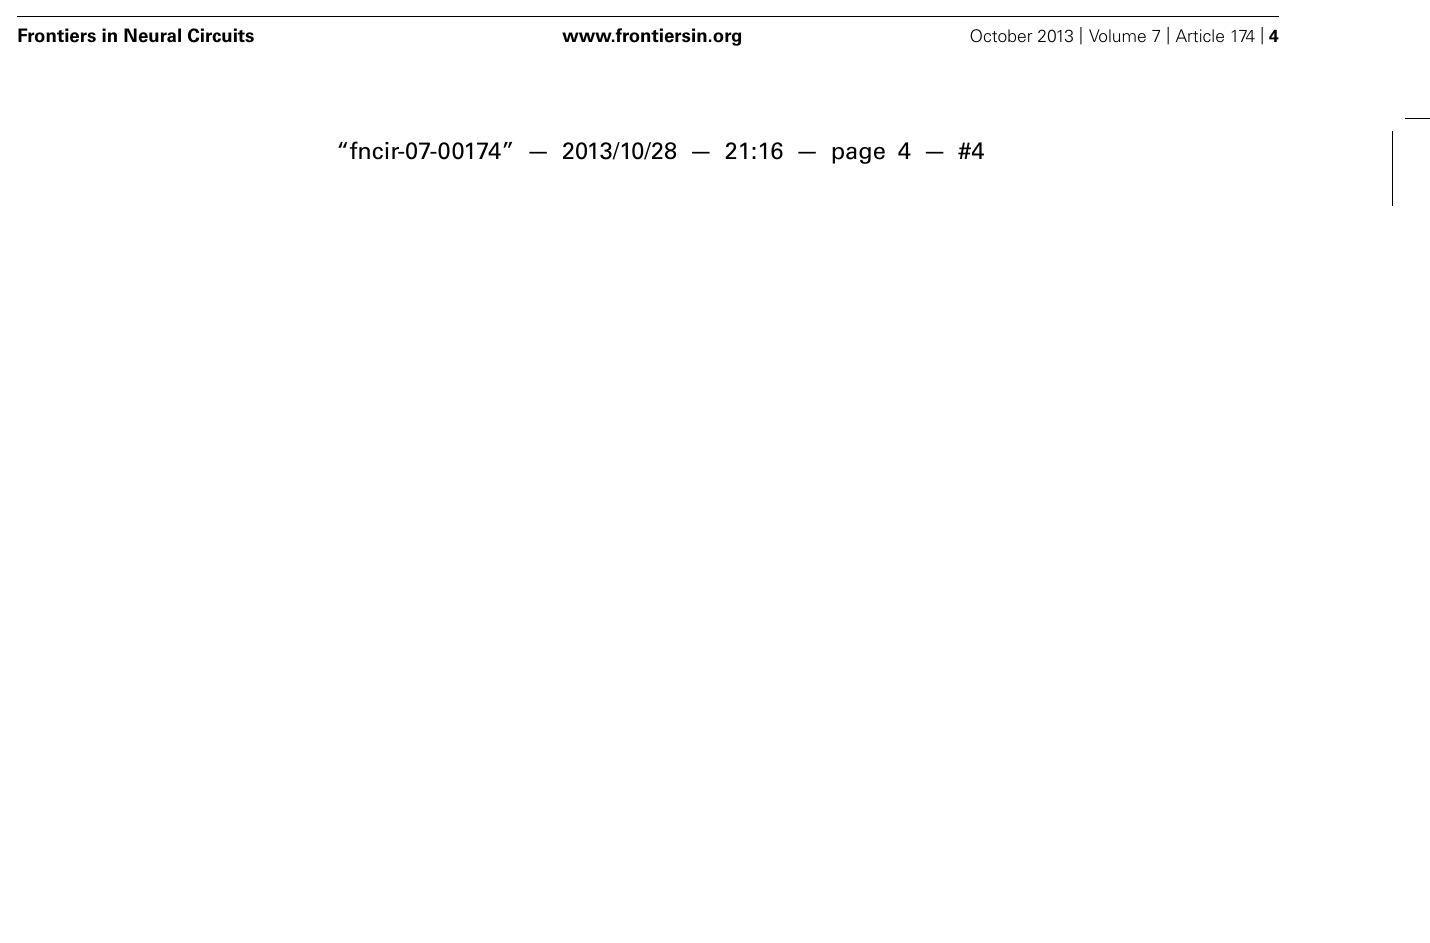
FIGURE 1 | HiDi isolates inputs that form neuronal tuning curves. (A) Left: a head angle of 20 ◦ to the horizontal combined with a 90 ◦ electrode approach was optimal for accessing a wide range of characteristic frequencies. Middle: range of characteristic frequencies (CFs) in three mice. Depths were measured from the brain surface (the zero point on the abscissa). Acoustically driven responses were not observed in the first